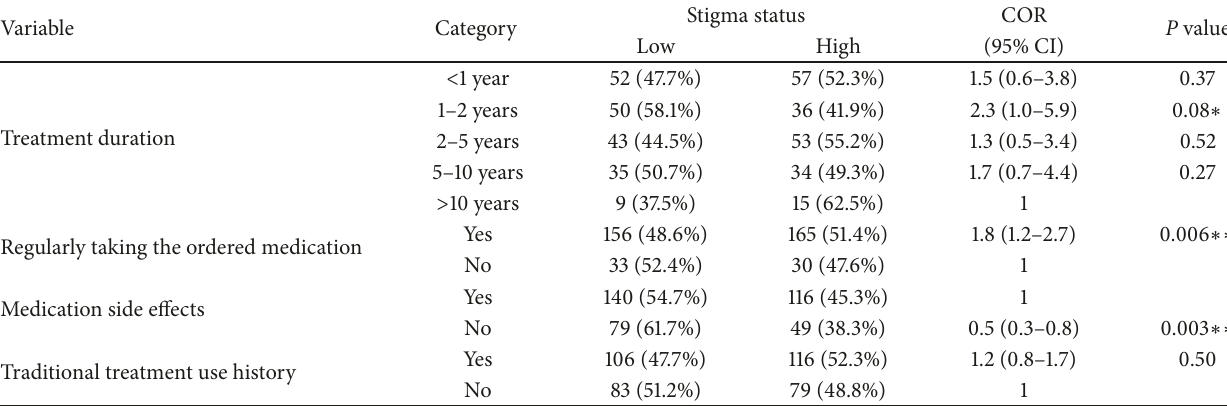
Table 5: Association of medication-related factors with perceived stigma among adults with mental illness in JUSH, 2012. Variable Category